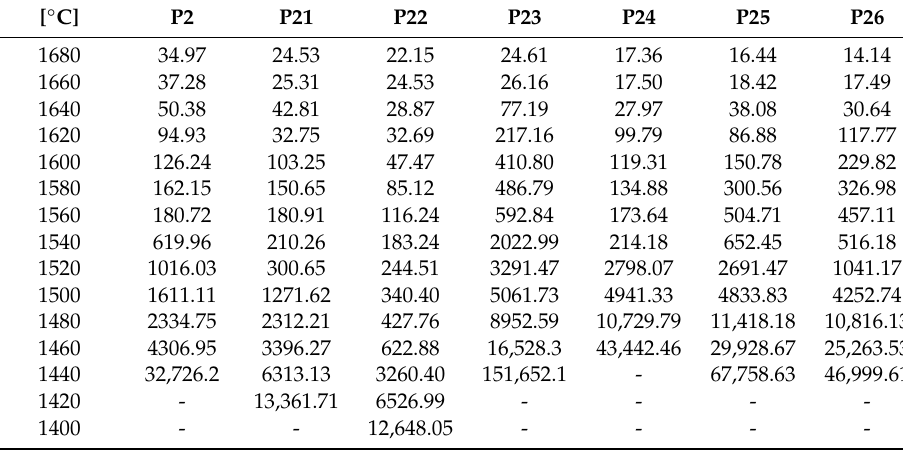
Table 6. Viscosity of the BOF slags with 8 mass% MgO [mPa*s].